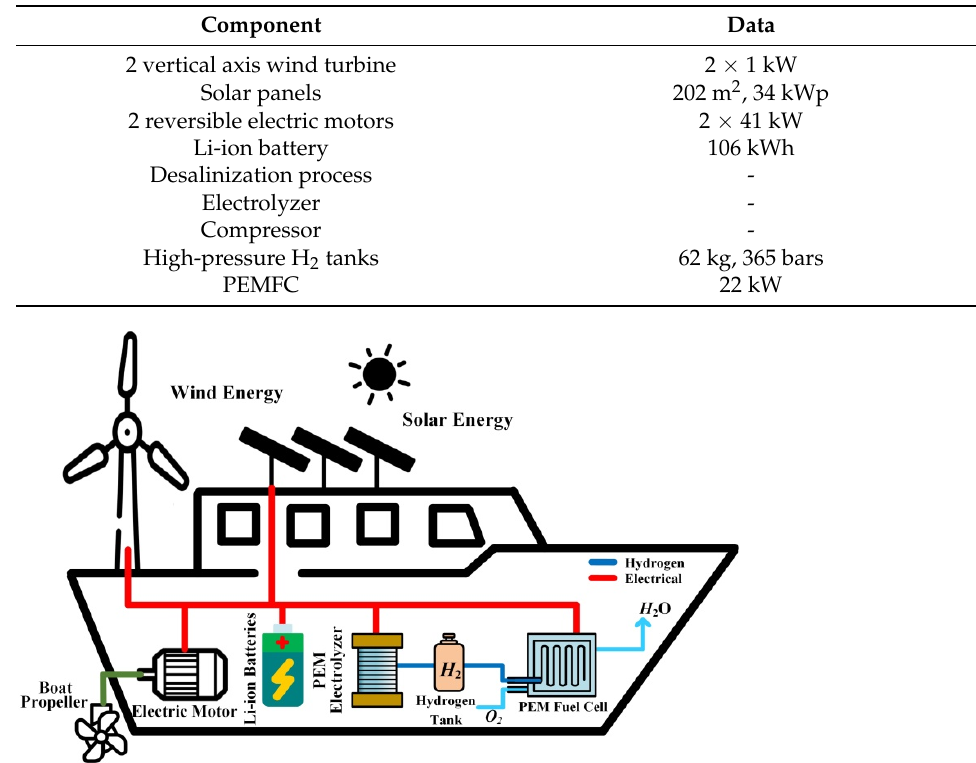
Table 2. Main specifications of the Energy Observer [61].